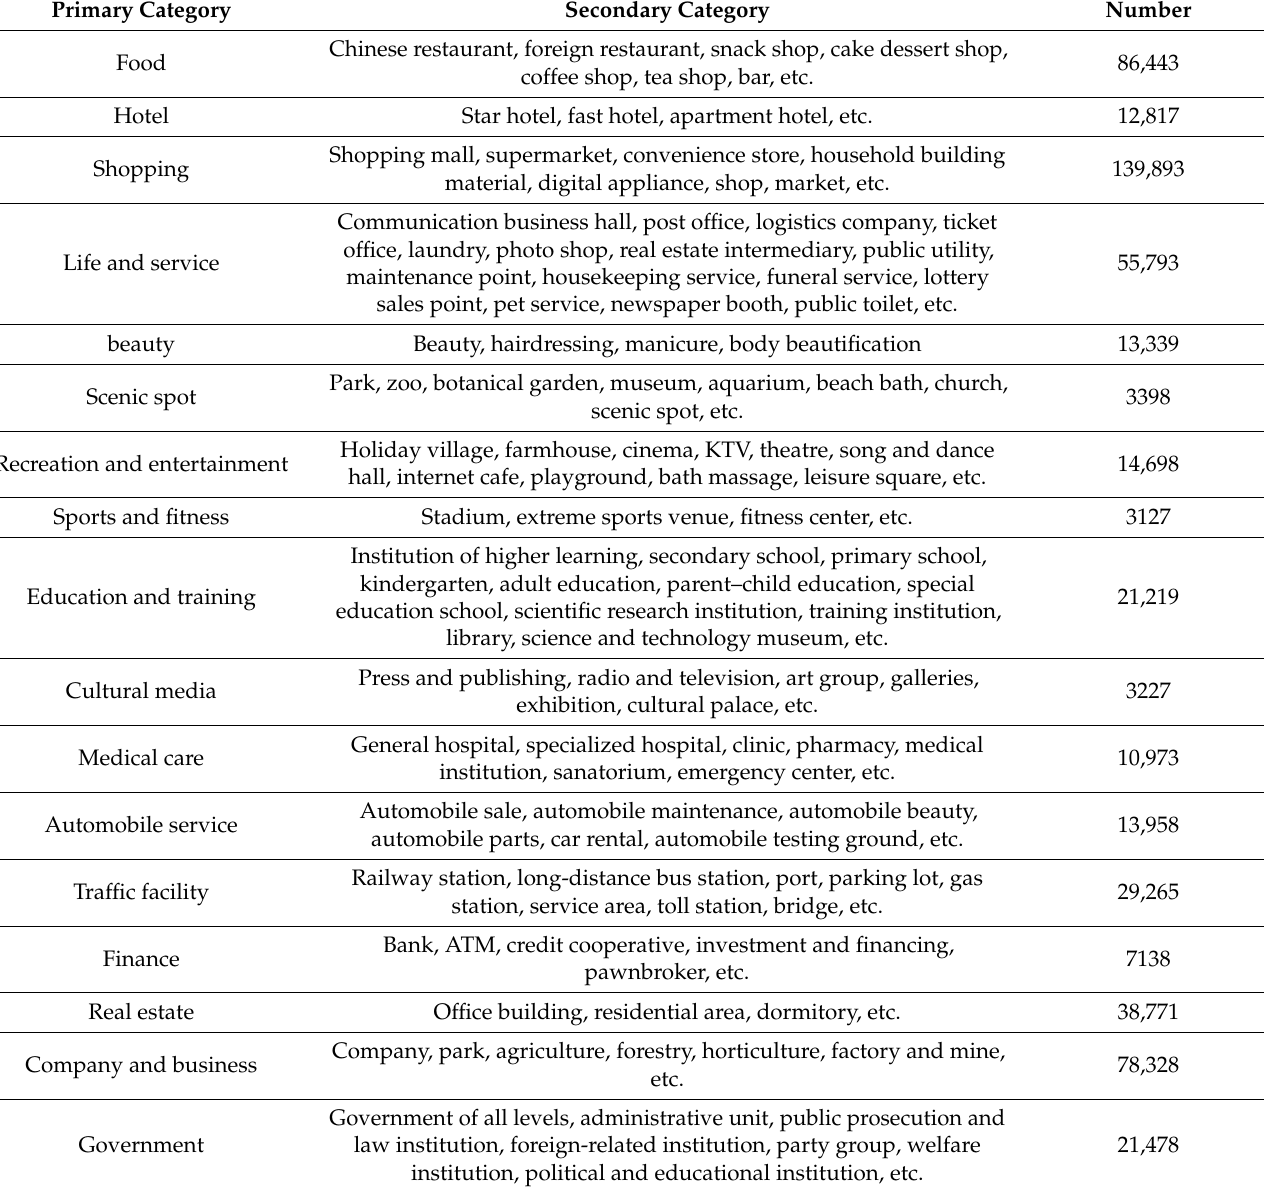
Table 1. The POI data and categories (from Baidu